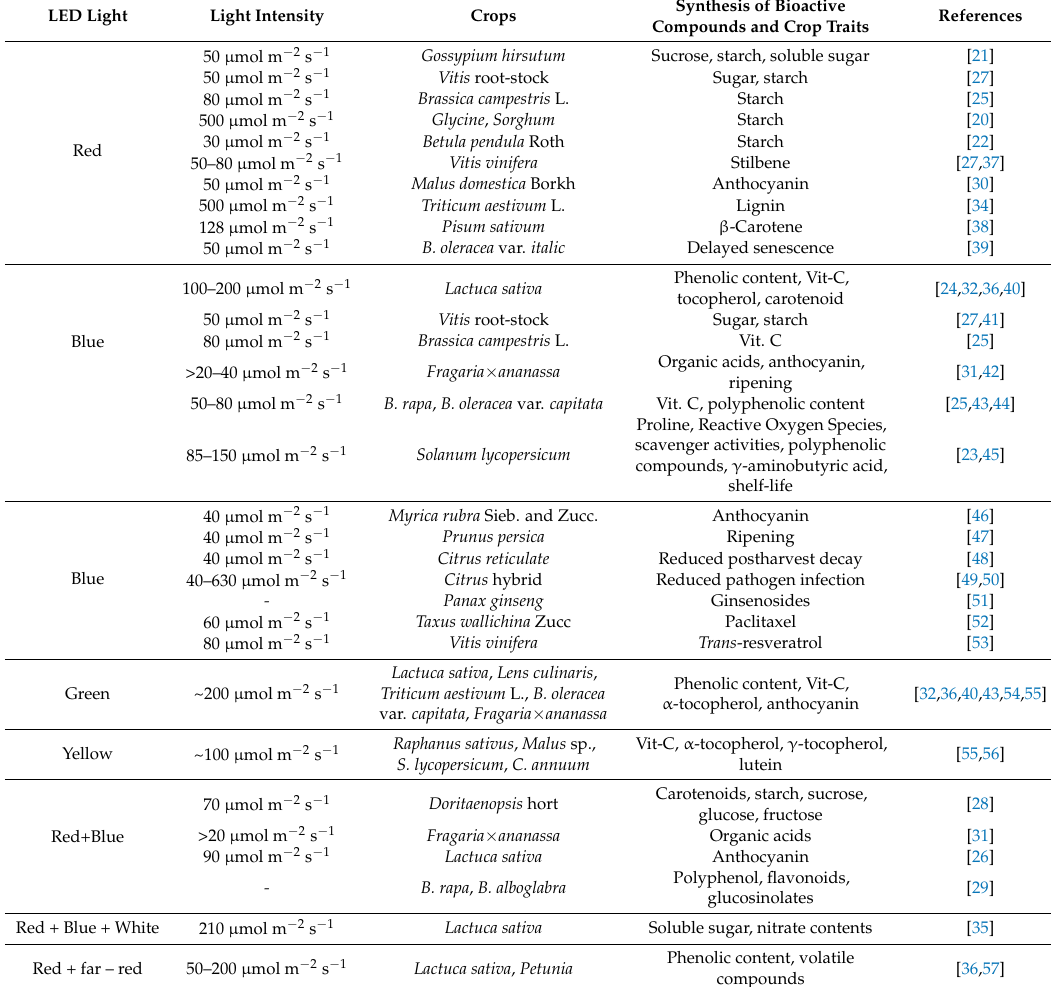
Table 1. Effect of LEDs on the synthesis of bioactive compounds and the quality of the crop produce. LED